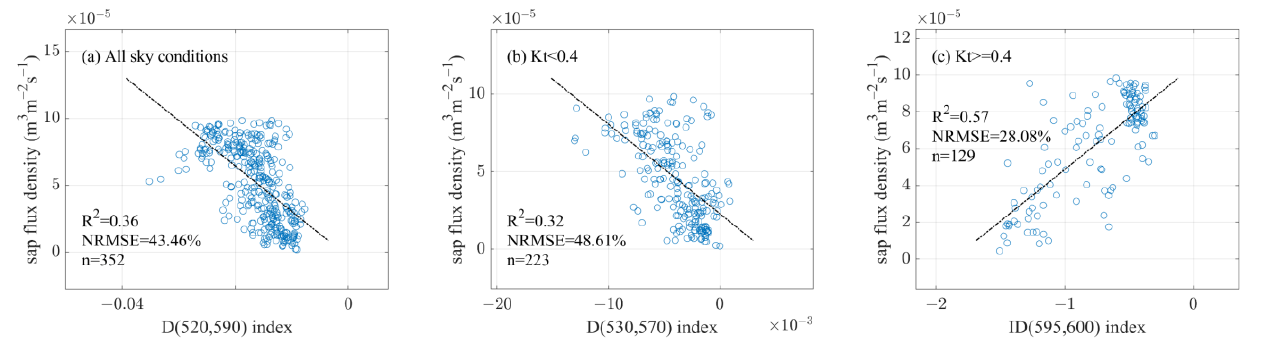
Figure 7. Relationships between the best indices identified and sap flux density (averaged to every 60 min) estimations under different sky conditions. ( a ) All-sky conditions, ( b ) cloudy or overcast sky conditions, ( c ) clear sky conditions.